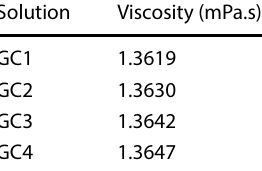
Table 3 Viscosity values for different aqueous solution of gelatin and chitosan